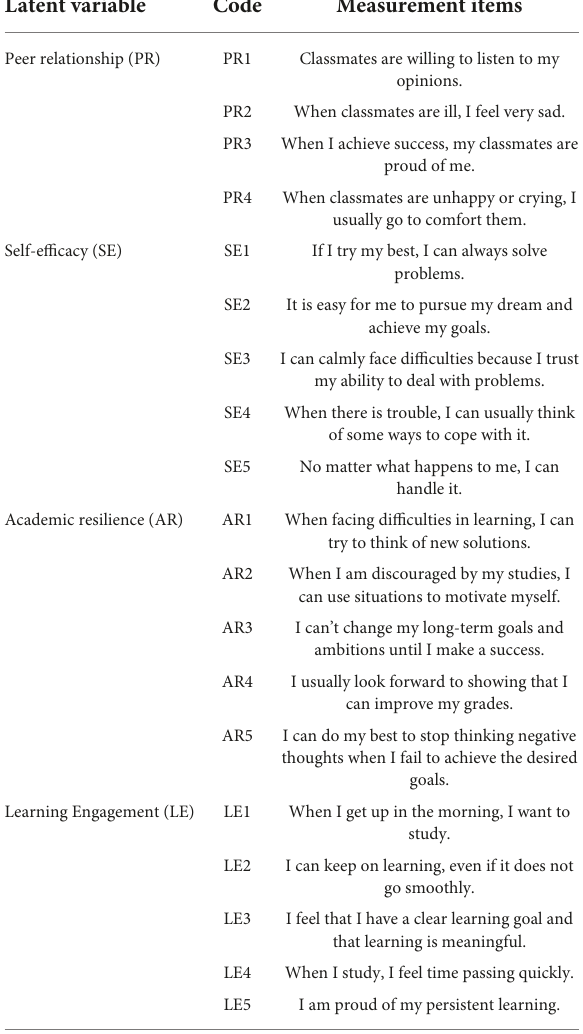
TABLE 1 Latent variables and items. Latent